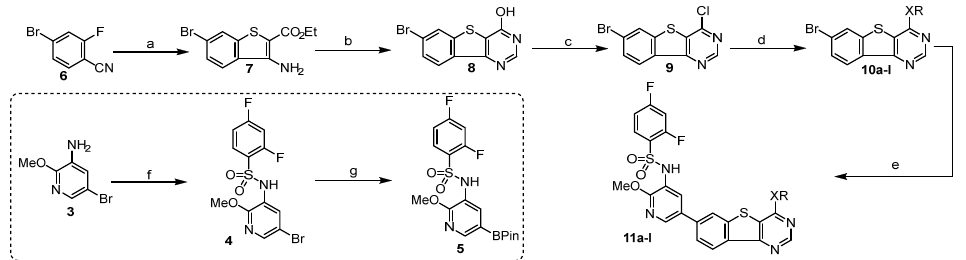
8 of 23 Figure 5. Flow cytometry analysis of cell cycle arrest of HCT-116 cells via PI staining after treatment with compound 22c at indicated concentration for 24 h . Figure 6. Analysis of the survival and apoptosis of HCT-116 cells induced by 22c via Hoechst 33342/PI staining. Normal cells show weak red fluorescence and weak blue fluorescence, while apoptotic cells show weak red fluorescence and strong blue fluorescence, the necrotic cells show strong red fluorescence and strong blue fluorescence . 3. Chemistry The target compounds could be formed via the Suzuki coupling of the borate of part A and the bromo compound consisting of parts B and C for the sake of the construction of